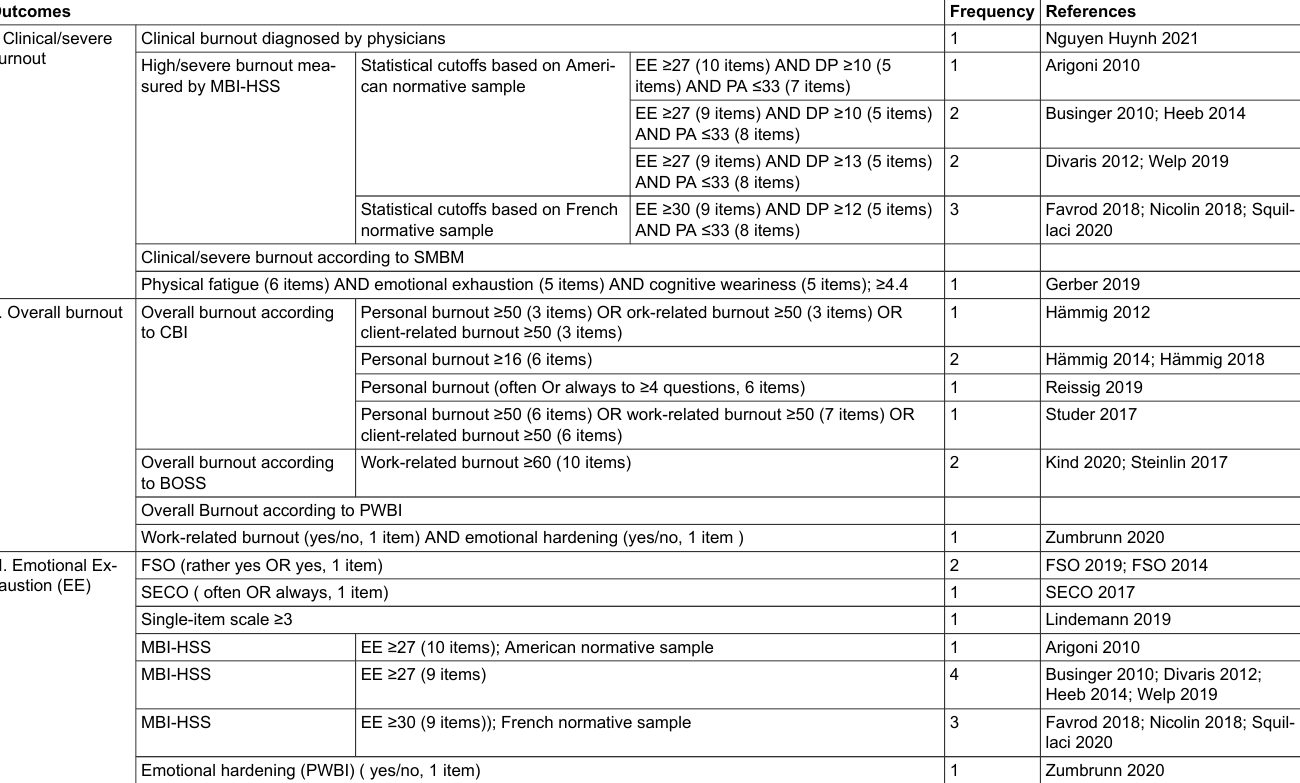
Table 2: Burnout outcome definitions: measures and